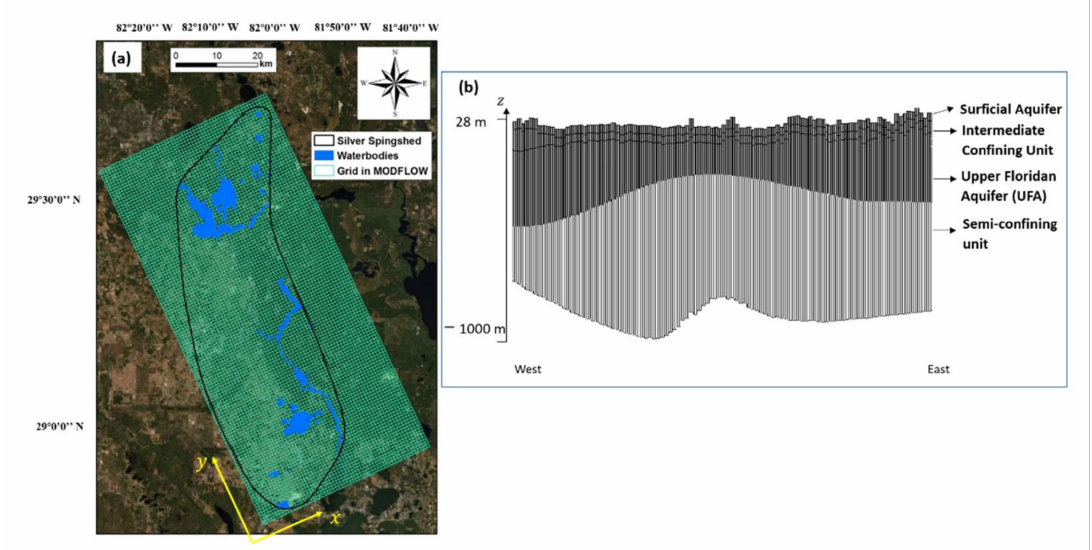
Figure 4. The horizontal ( a ) and vertical ( b ) discretization of the groundwater model [32].